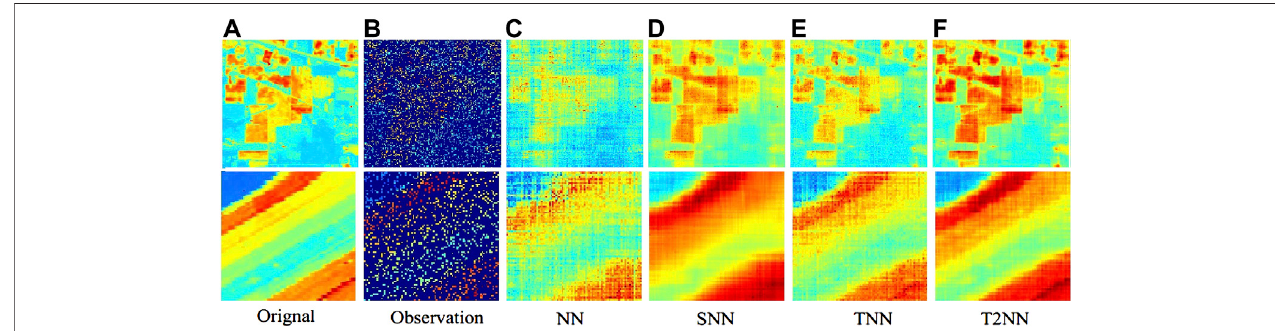
FIGURE4| Visualresultsobtainedbyfournormsfornoisytensorcompletionwith85%missingentriesonthehyperspectraldataset(graydatashownwithpseudo- color). The fi rst and second rows correspond to Indian Pines and Salinas A , respectively. The sub-plots from (A) to (F) : (A) a frame of the original data, (B) the observed frame, (C) the frame recovered by NN [30], (D) the frame recovered by SNN [22], (E) the frame recovered by the vanilla TNN [25], and (F) the frame recovered by our T2NN.